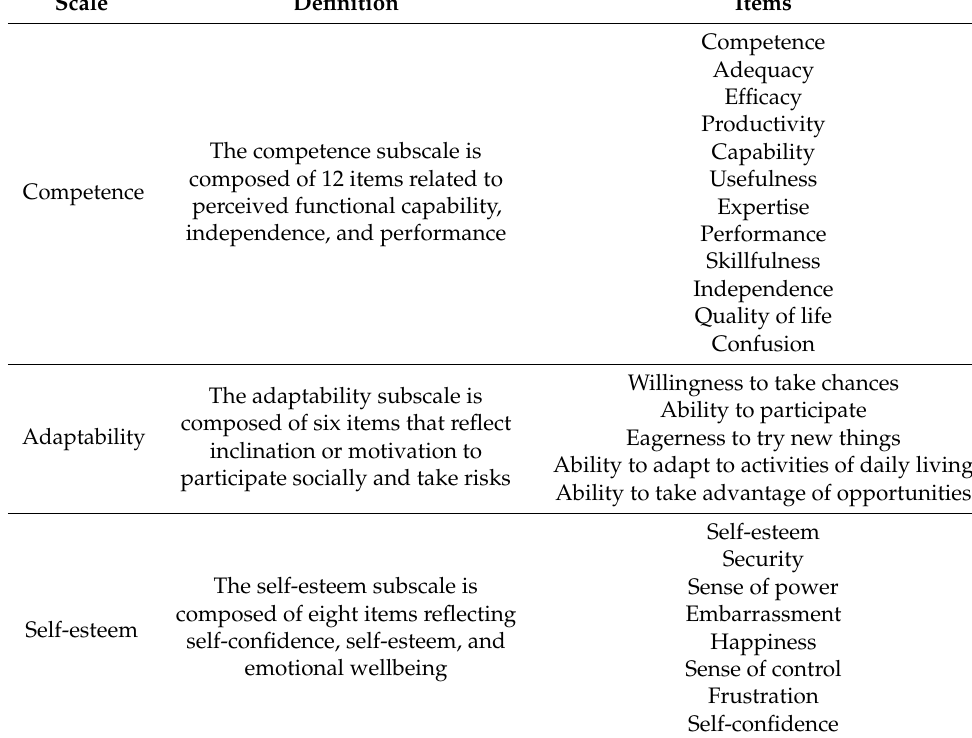
Table 1. PIADS constructs and